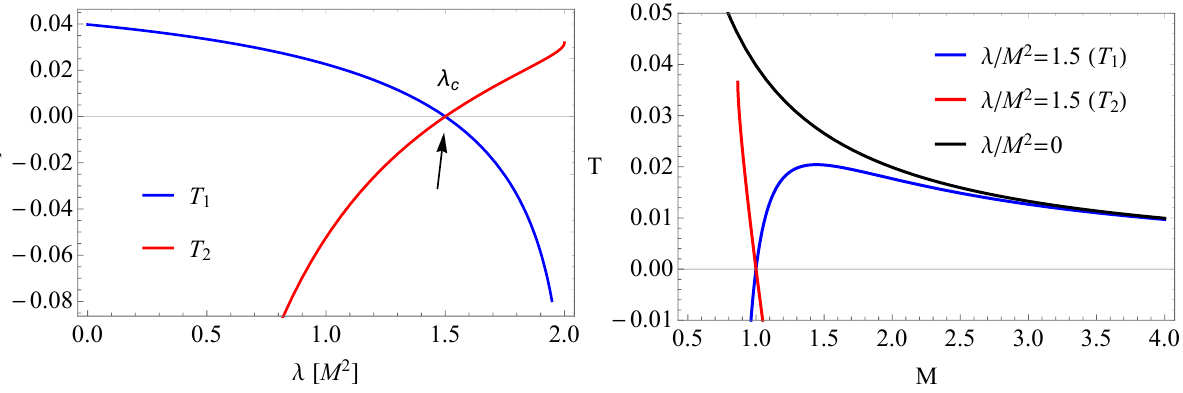
Figure 4. Left panel :The plot showing Hawking temperature of the 4D SCBH as a function of the coupling parameter λ for a fixed mass of the black hole M = 1. Right panel : The plot showing Hawking temperature of the 4D SCBH as a function of black hole mass for fixed values of the coupling parameter λ